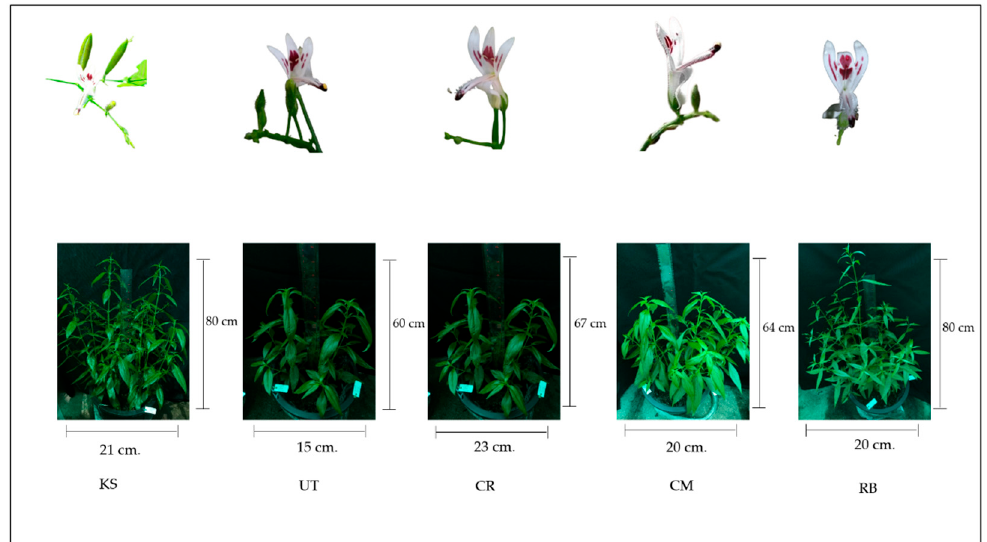
Figure 1. Taxonomical characteristics of 5 collections of Andrographis paniculata. KS = Kamphaeng Saen, UT = Udon Thani, CR = Chiang Rai, CM = Chiang Mai, RB =